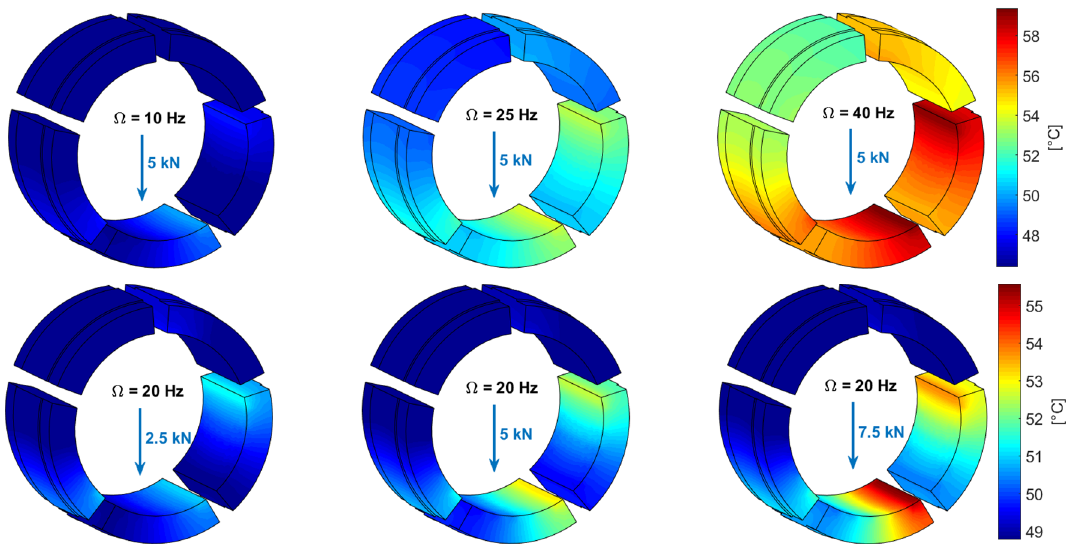
Figure 18. Predicted temperature distribution on all pads as a function of shaft speed ( upper ) and applied static load ( lower ) in the test bearing.